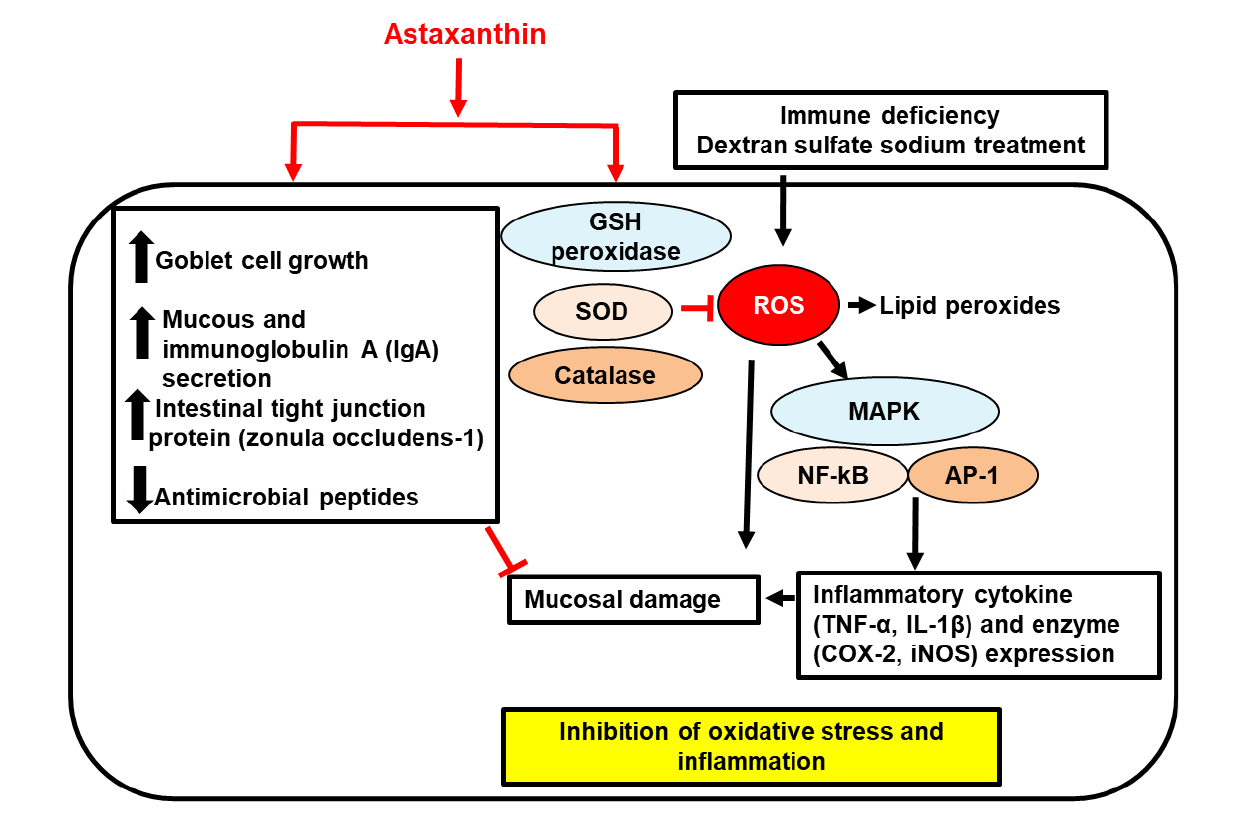
Figure 3. The proposed mechanism of astaxanthin-mediated protective effects on ulcerative colitis. In experimental ulcerative colitis model, induced by treatment of dextran sulfate sodium or immune deficiency, astaxanthin increased glutathione (GSH) peroxidase, superoxide dismutase (SOD), and catalase which decreases reactive oxygens species (ROS) and lipid peroxide production. Therefore, astaxanthin inhibits ROS-mediated activation of mitogen-activated protein kinases (MAPK), nuclear factor- κ B (NF- κ B), and activator protein 1 (AP-1) to induce expression of inflammatory cytokines such as tumor necrosis factor- α (TNF- α ) and interleukin (IL)-1 β , and inflammatory enzymes including cyclooxygenase-2 (COX-2) and inducible nitric oxide synthase (iNOS), which stimulates mucosal damage. Thus, astaxanthin inhibits oxidative stress-mediated inflammation. Moreover, astaxanthin stimulates goblet cells growth and secretion of mucous and immunoglobulin A (IgA), and expression of zonula occludens-1 which is intestinal tight junction protein; however, it reduces anti-microbial peptides. Overall, astaxanthin ameliorates intestinal mucosal damage. Inhibit, ; increase, ; decrease, . Red arrows represent the effects of astaxanthin. 5. Colon Cancer Colon cancer has become the third most common cancer in men and women [114]. Although colon cancer can be inherited, several epidemiological studies have shown that the risk of colon cancer is largely determined by environmental factors such as high alcohol consumption, low-fiber diet, high-fat diet, and smoking tobacco [148,149]. In addition, studies have well-established the molecular links between chronic inflammation and oxidative stress, and colorectal carcinogenesis [150,151]. Although the molecular mechanisms by which ROS and inflammation promote carcinogenesis are still being elucidated, redox-sensitive transcription factors such as NF- κ B, AP-1, and STAT3 have been strongly implicated in colon carcinogenesis [152]. Therefore, various chemoprotective agents, anti-oxidants, and anti-inflammatory bioactive compounds have been identified to provide molecular strategies for colon cancer by modulating abnormally activated NF- κ B, AP-1, and STAT3.